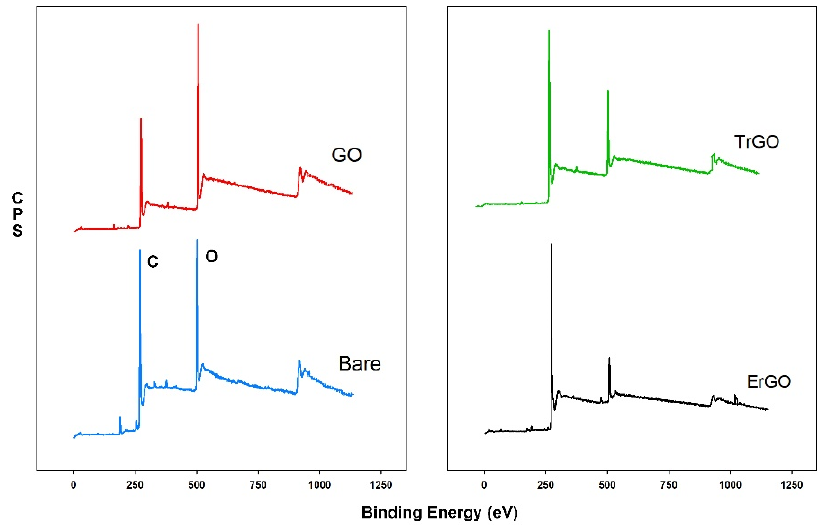
Figure 2. XPS wide scan spectra of a bare electrode and GO-, ErGO-, and TrGO-modified electrodes. The C/O ratios of these electrodes were 3.97, 2.49, 10.52, and 5.7,